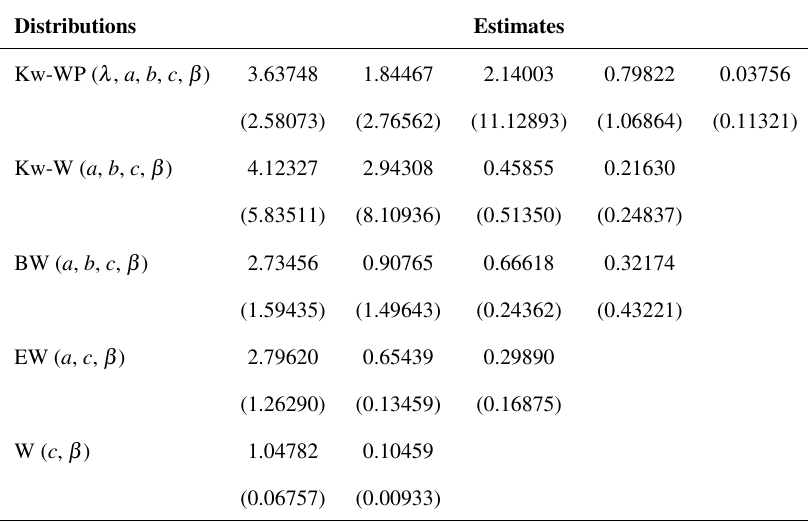
Table 1. MLEs (standard errors in